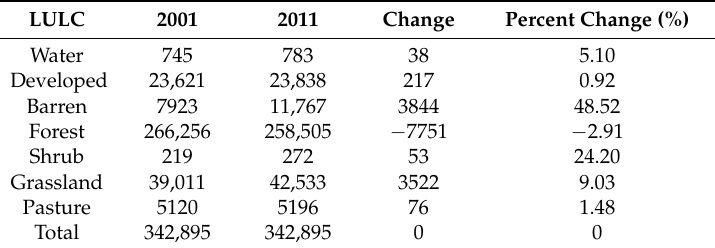
Table 2. Area of each land use land cover (LULC) type in 2001 and 2011 (unit, hectares) and its changes (unit,